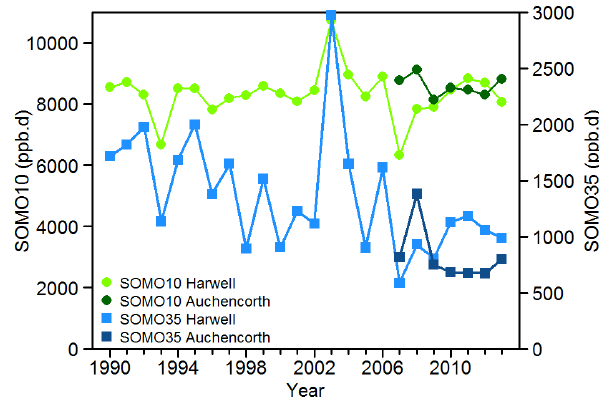
Figure 3. Human health-relevant exposure to O 3 at Harwell (1990– 2013) and Auchencorth (2007–2013), as characterised by the SOMO10 and SOMO35